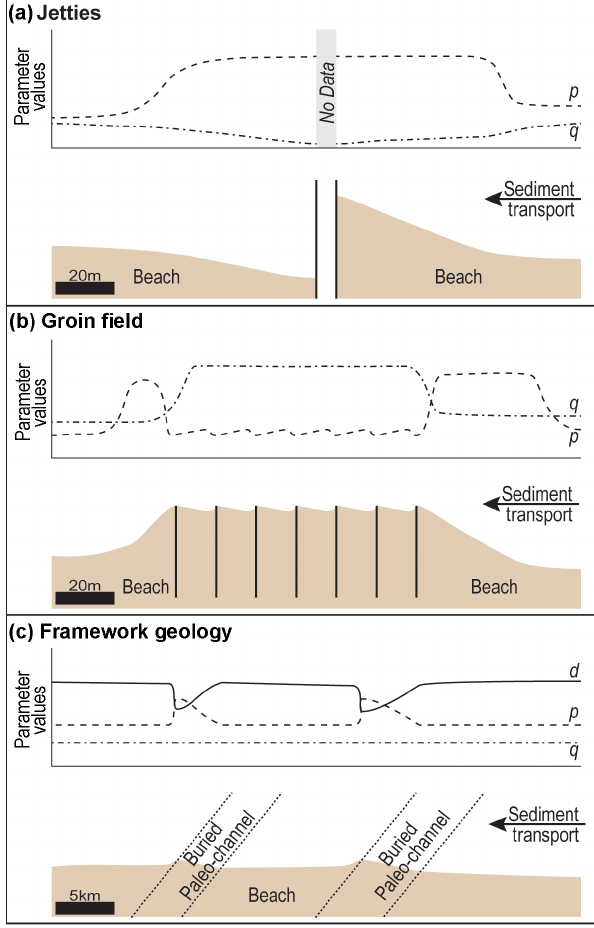
Figure 2. Sample beach–dune alongshore data series and ARFIMA model parameters ( p = AR; d = LRD; and q = MA) for three coastal geomorphology scenarios. (a) Jetties trap sediment on the beach up-drift side and starve the down-drift beach of sediment (see Ocean City, Maryland, USA), resulting in increased AR values on either side of the jetty. (b) Groin fields can trap sediment between the groins within the field, while starving the down-drift beach of sediment. In this case, beach volume at a particular location within the field can be modeled as the MA of adjacent beach volume measurements. Outside of the groin field, beach volume may in- crease/decrease, resulting in increased AR values and decreased MA values. (c) Framework geology, such as infilled paleo-channels, influences coastal geomorphology on broader spatial scales (see “oblique sandbars” in the Outer Banks, North Carolina, USA; Mc- Ninch, 2004) and is much more likely to appear in the LRD values. While coastal morphology at broad scales is influenced by the entire data series, sediment transport gradients can be influenced by more localized processes, resulting in an inverted trend with the AR com- ponent. The degree to which a particular point is influenced by the entire data series at a particular scale can be modeled and plotted using the LRD